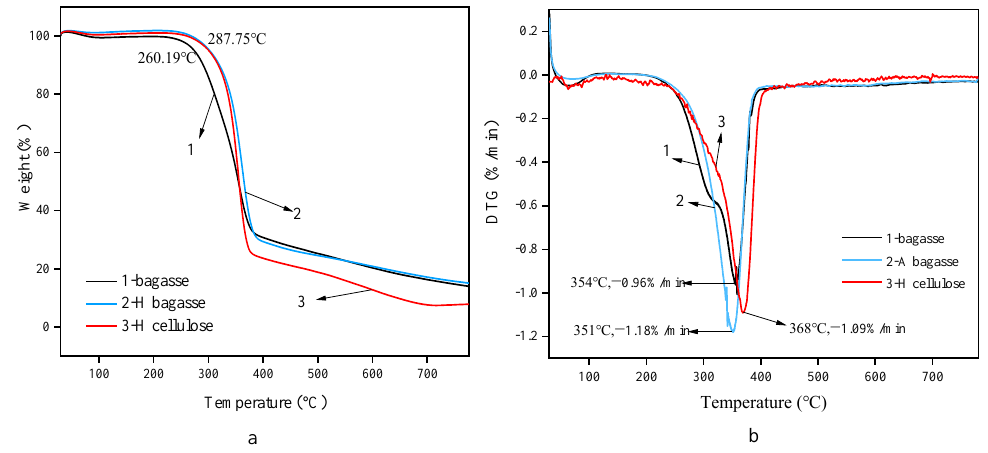
Figure 9. Thermogravimetric curves TG ( a ) and DTG ( b ) of two stages of alkaline extraction. (Thereinto,1-bagasse; 2-bagasse extracted by alkali AB; 3-alkali cellulose Ac). In the 240 °C to 390 °C range, the three curves exhibit a distinct descent and a very high mass loss rate. The respective maximum weight loss rates were 0.96%/min, 1.18%/min, and 1.09%/min in the 350 °C to 370 °C range.